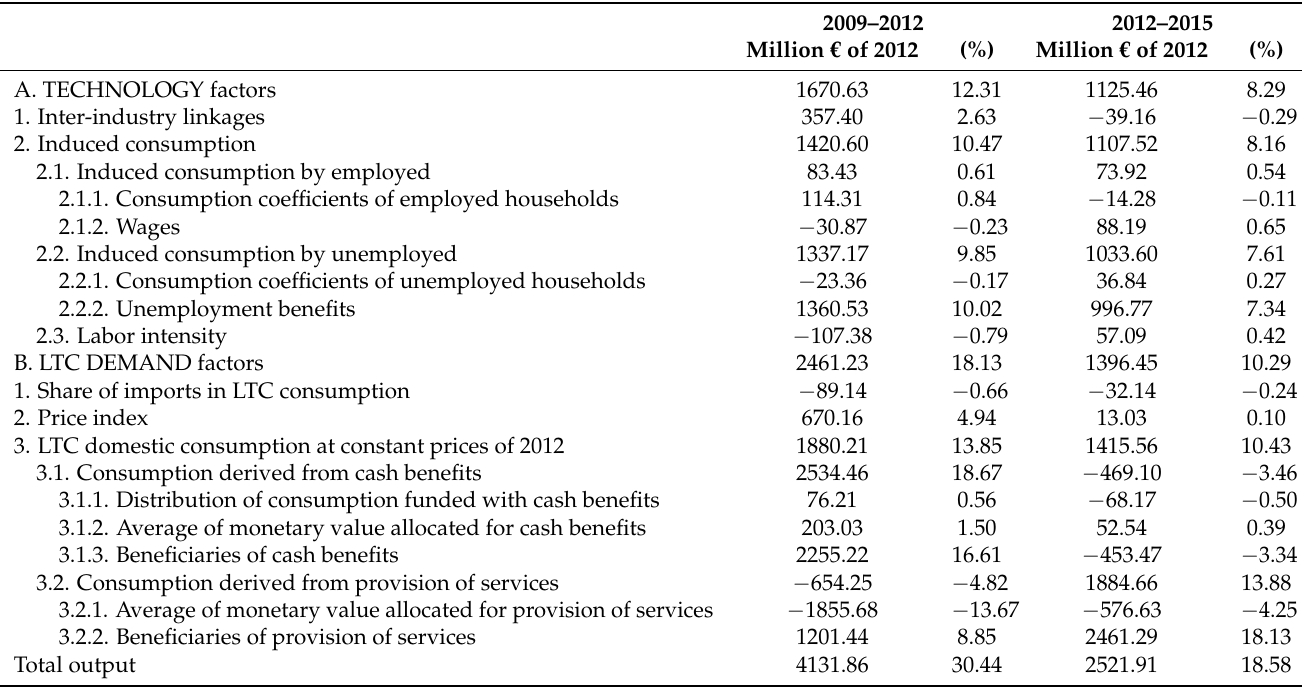
Table 3. SDA of the output x LTC generated by LTC